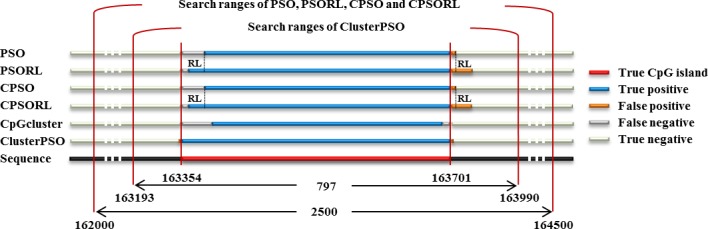
Results of the position of the true CpG island and the positions of the detected CpG islands using the PSO-based methods and ClusterPSO.The search regions for PSO-based methods are also shown to illustrate the difficulty in finding the optimal CpG island. True positive, false positive, false negative and true negative outcomes are clearly shown for comparison between the six methods.